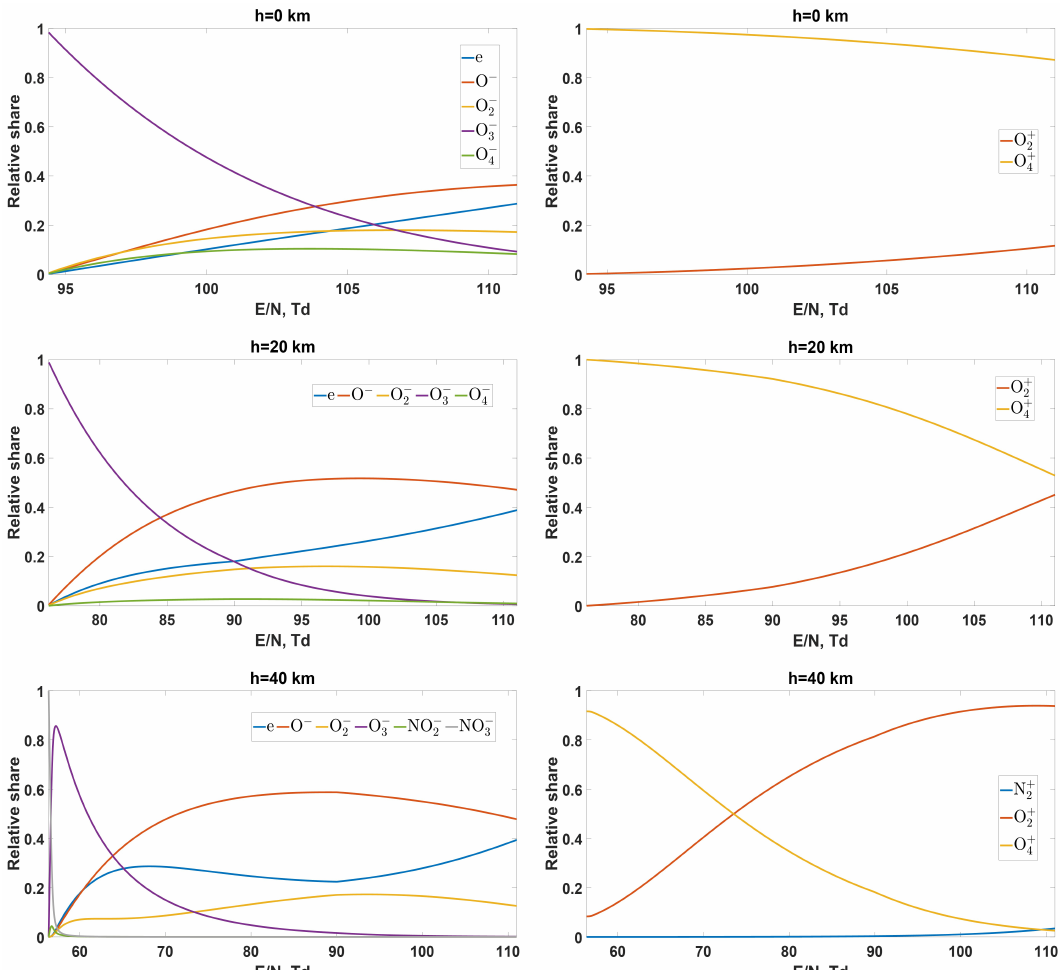
Figure 4. Dependence curves of charged particles composition on reduced electric field E / N for different altitudes AMSL. The lower reduced electric field limits correspond to critical breakdown fields E c at the considered altitudes. Components with negligible relative fractions are not